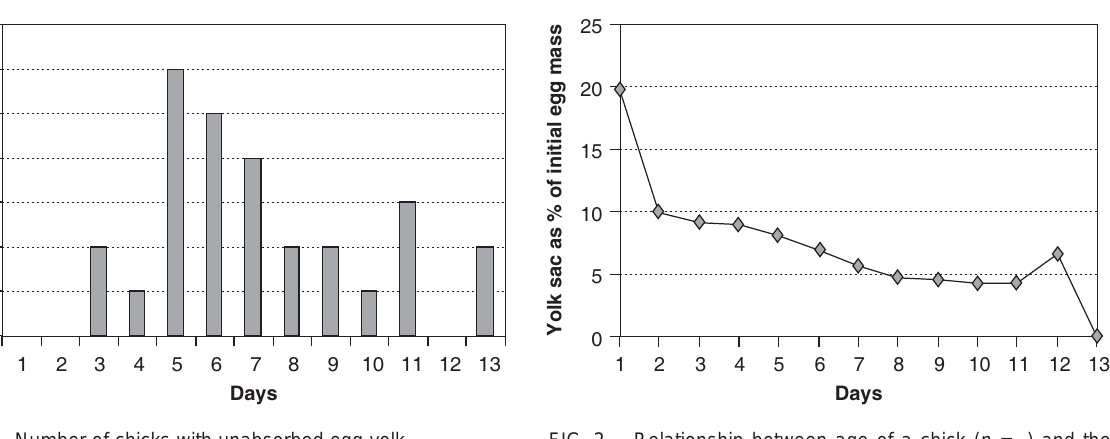
FIG. 1 Number of chicks with unabsorbed egg yolk FIG. 2 Relationship between age of a chick ( n = ) and the mass of the residual yolk expressed as percentage of the initial egg mass from which the chick